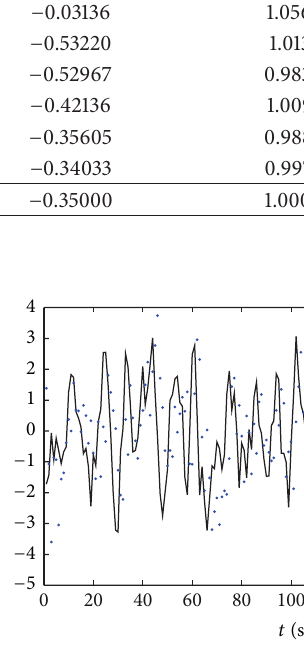
Figure 2: The state estimation errors 𝛿 versus 𝑡 ( 𝜎 2 = 0.20 2 ). Solid